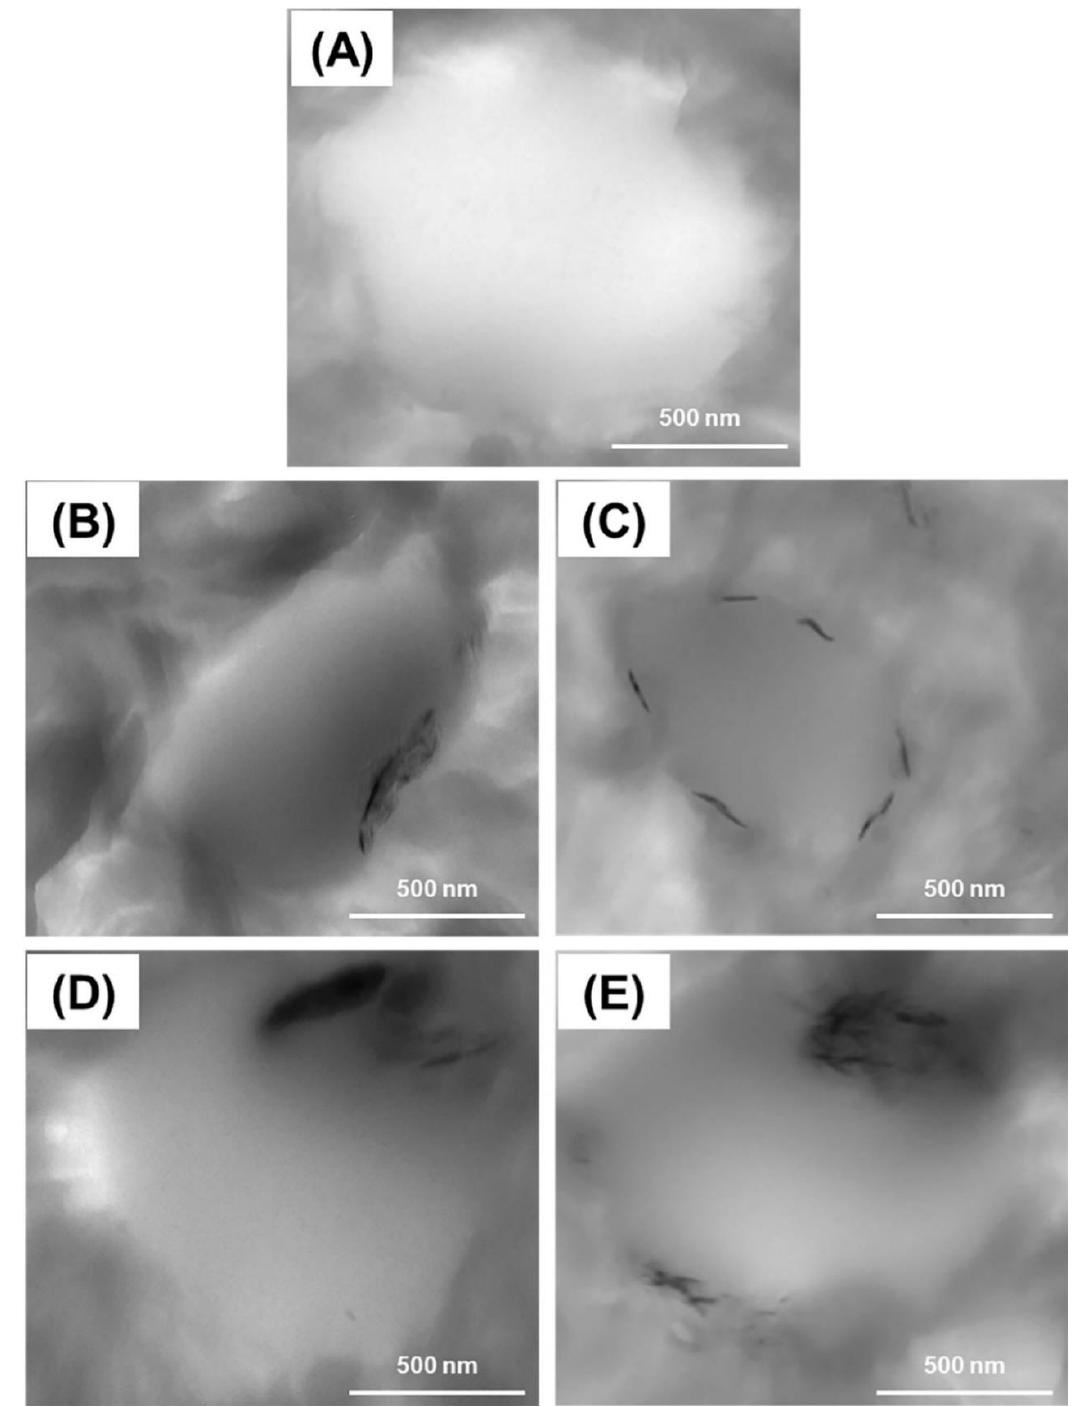
Figure 2. TEM images of PE90 ( A ), PE90GO2 ( B ), PE90RGO2 ( C ), PE90GO4 ( D ), and PE90RGO4 ( E ).